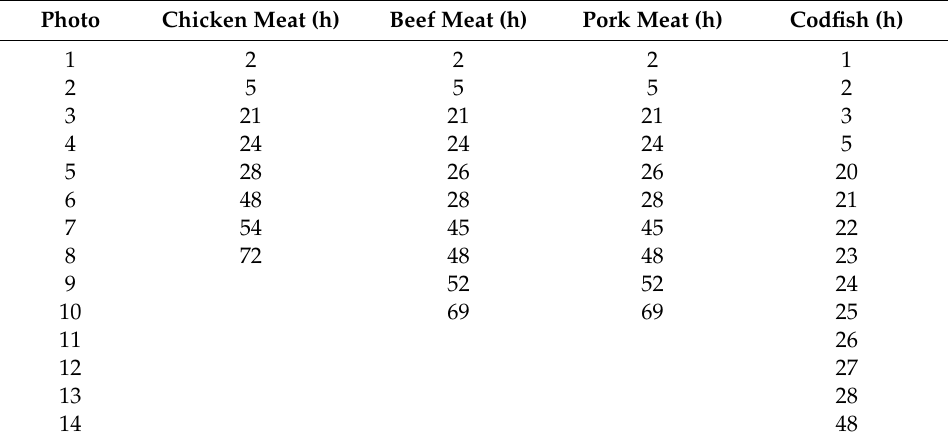
Table 3. Photo acquisition times for di ff erent foods, expressed in hours from the preparation.